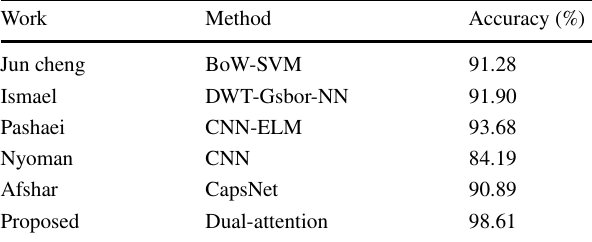
Table 4 Related works and comparison using figshare dataset